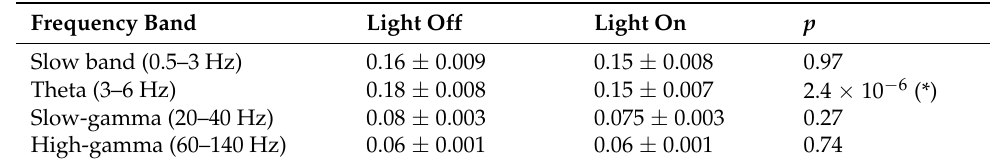
Table 3. Changes induced by light on Granger causality from the septal LFP to hippocampal LFP (MS LFP -> HP